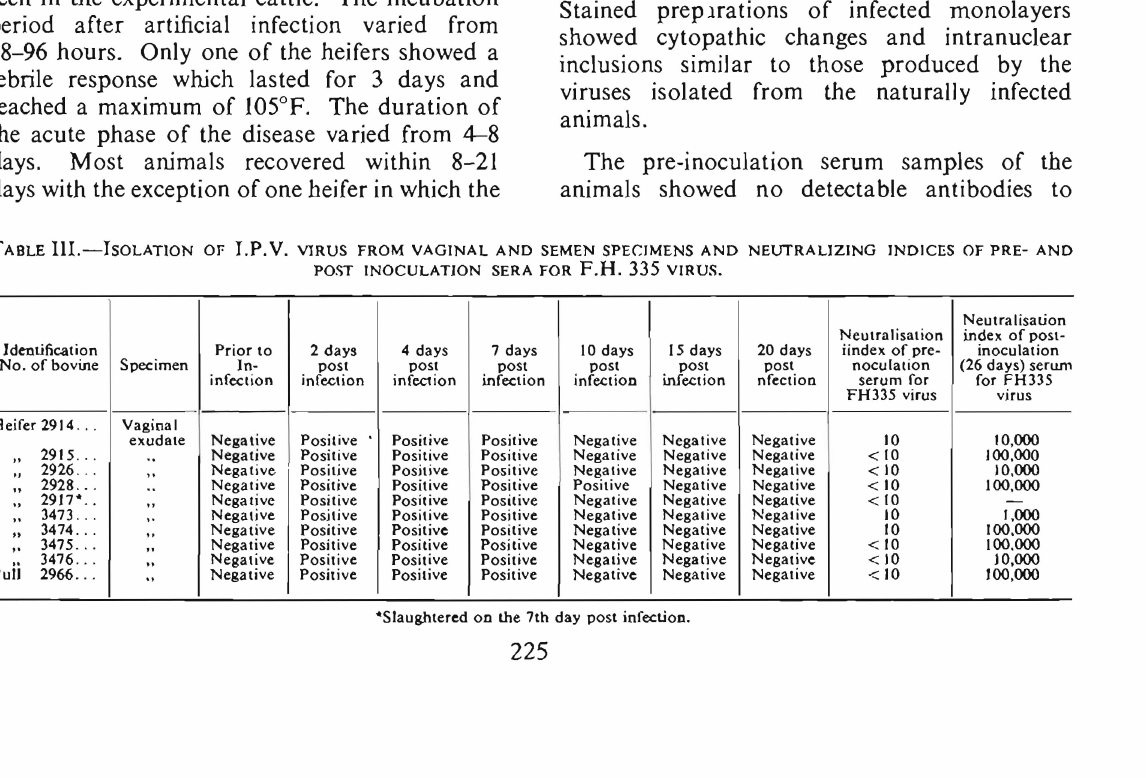
Figure IV. Section of vaginal mucosa showing lymphocytic and neutrophilic infiltration.